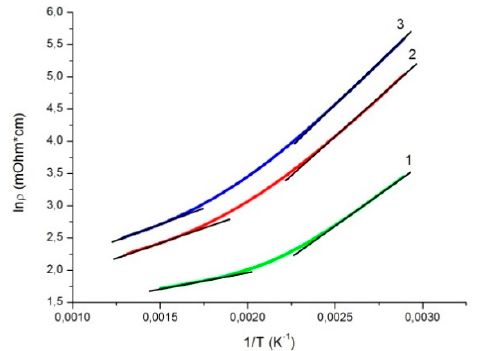
(b) Figure 4. Temperature dependences of the resistivity and thermopower (insets) during ( а ) the first heating and ( b ) the third cooling. The anomalies in the behavior of the Seebeck coefficient correlated with the data of thermogravimetric analysis of the sample mass loss caused by the removal of oxygen and are observed at much lower temperatures than in the behavior of the resistivity (Figure 4 а ). The oxygen nonstoichiometry index δ increased from one heating ‒ cooling cycle to another and the deviation from the semiconductor-type conductivity shifted toward higher temperatures. At δ = 0.21, the temperature dependency of the resistivity was qualitatively consistent with the